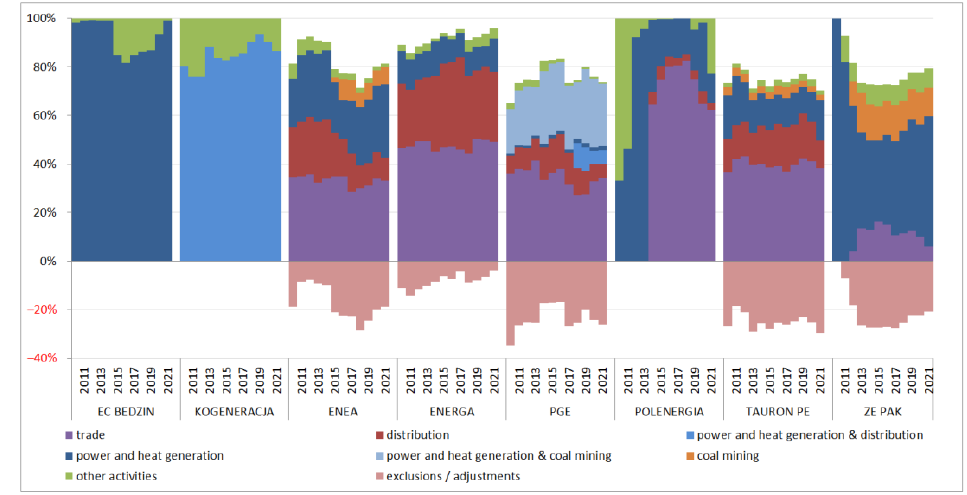
Figure 4. Structure of total sales revenues (to external customers + inter-segment sales) of the surveyed energy companies by business segment. Source: own elaboration.